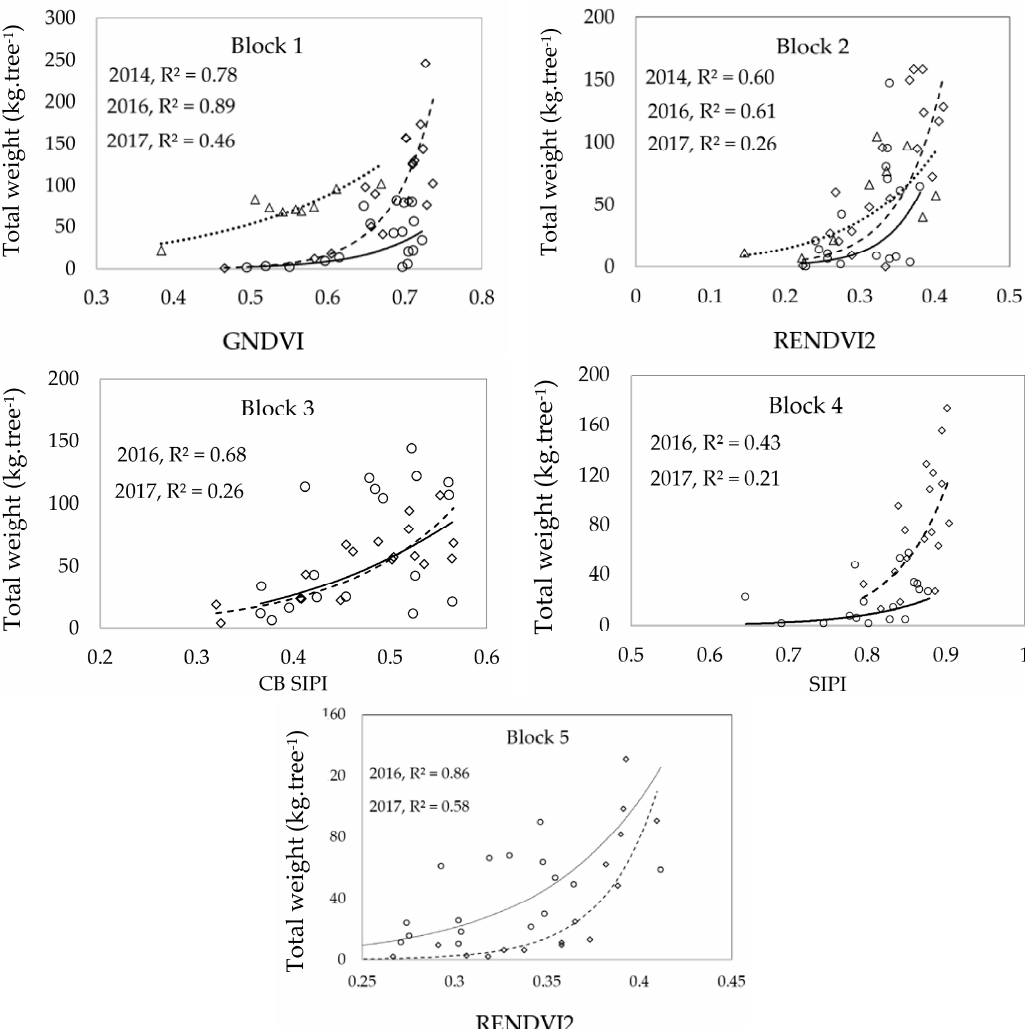
Figure 5. Scatter plot between those VIs identified to have the highest coefficient of determination to total fruit weight (kg·tree − 1 ) for each sampled block derived from WorldView-2 (WV2) and WV3 imagery. The 2014 sample points are presented as a triangle ( ∆ ) (n = 9 per block) in blocks 1 and 2, with 2016 as a diamond ( ◊ ) (n = 18 per block) and 2017 as circle (o) (n = 18 per block). For average fruit size (g), scatter plots of the optimal VIs were again derived for each separate block (Figure 6). Unlike total fruit weight (kg·tree − 1 ), strong coefficients of determination were achieved across all three seasons for Block 1 (RENDVI1: R 2 = 0.78 with RMSE = 13 g (2014), R 2 = 0.65 with RMSE = 24.8 g (2016) and R 2 = 0.41 with RMSE = 43.7 g (2017)) and Block 2 (RENDVI1: R 2 = 0.64 with RMSE = 18.78 g (2014), R 2 = 0.77 with RMSE = 15.83 g (2016) and R 2 = 0.68 with RMSE = 33.5 g (2017)). For the remaining blocks sampled during the 2016 and 2017 growing season, a respectable coefficient of determination were also identified: Block 3 (RENDVI2, R 2 = 0.45 with RMSE = 20.96 g); Block 5 (RENDVI2, R 2 = 0.41 with RMSE = 43.32 g) and Block 4 (SIPI, R 2 = 0.35 with RMSE 88.98 g).